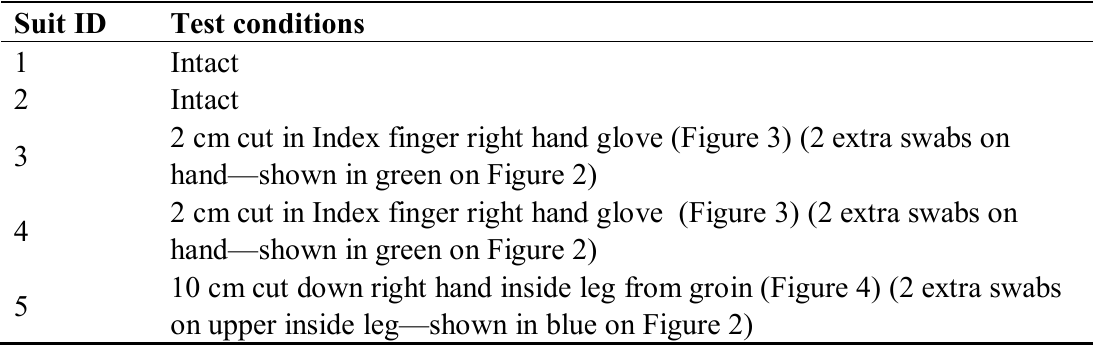
Table 1. Summary of tests performed on a number of